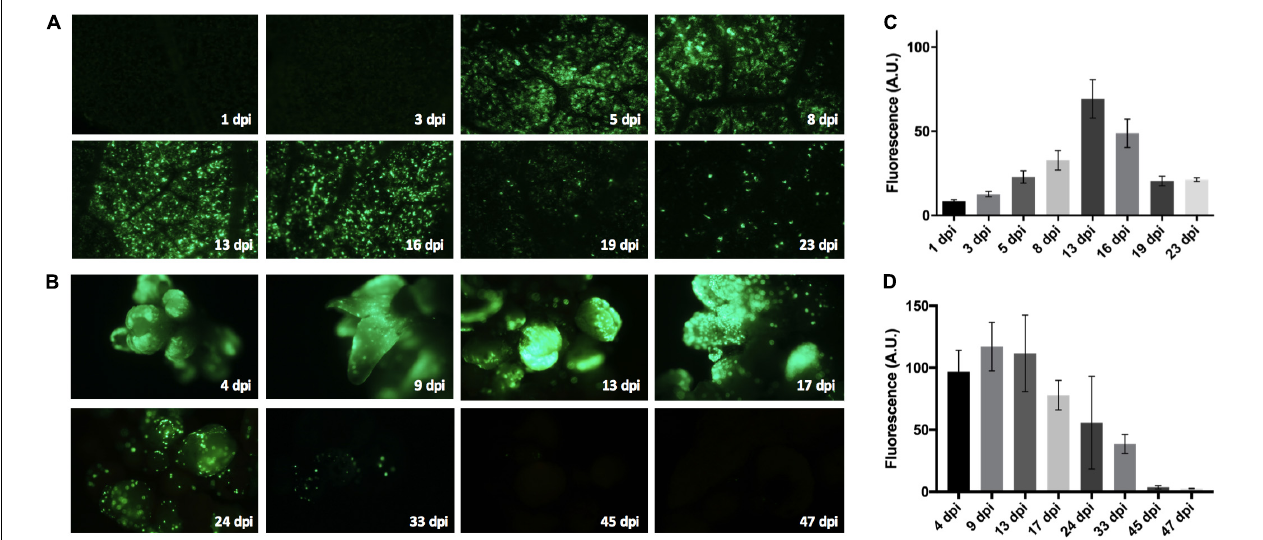
FIGURE 1 | Bean yellow dwarf virus (BeYDV)-derived vector behavior in ‘Thompson Seedless’ grapevine. An LSL vector based on the BeYDV and harboring a green fluorescent protein ( GFP ) expression cassette was used in gene transfer experiments in leaves (A) and somatic embryos (B) . Both explants were evaluated at different days post-infiltration (dpi) using an epifluorescence microscope to acquire digital images for each time point. Eight images per dpi time point were processed using ImageJ software to quantify the light intensity per pixel in the green channel. Leaf images were evaluated from vacuum agroinfiltrations of whole plants. The mean light intensities for the leaves (C) and somatic embryos (D) were calculated to produce intensity plots with the means represented as arbitrary units (A.U.) of fluorescence per pixel. The mean intensities were subjected to one-way ANOVA. Three full-length experiments were performed. Standard error bars are